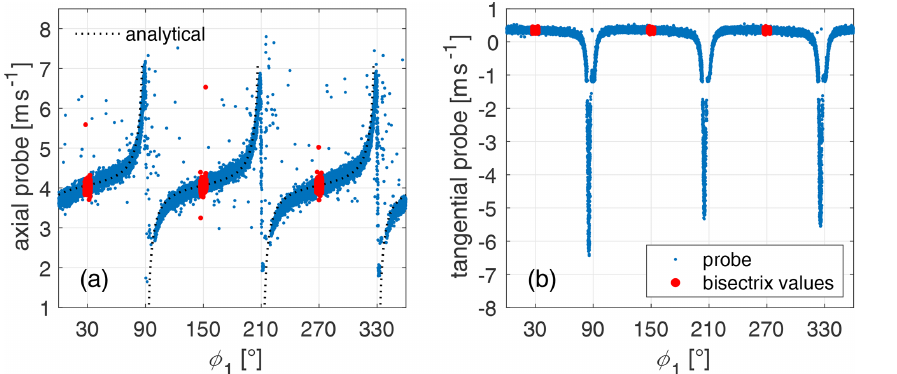
Figure 5. (a) Measurements of axial probe for high load case at a radius of 0.7 R for 400 revolutions over azimuth angle φ 1 with marked data within the bisectrix threshold. φ 1 = 0 ◦ relates to the 12 o’clock position of blade 1; (b) analogously for the tangential